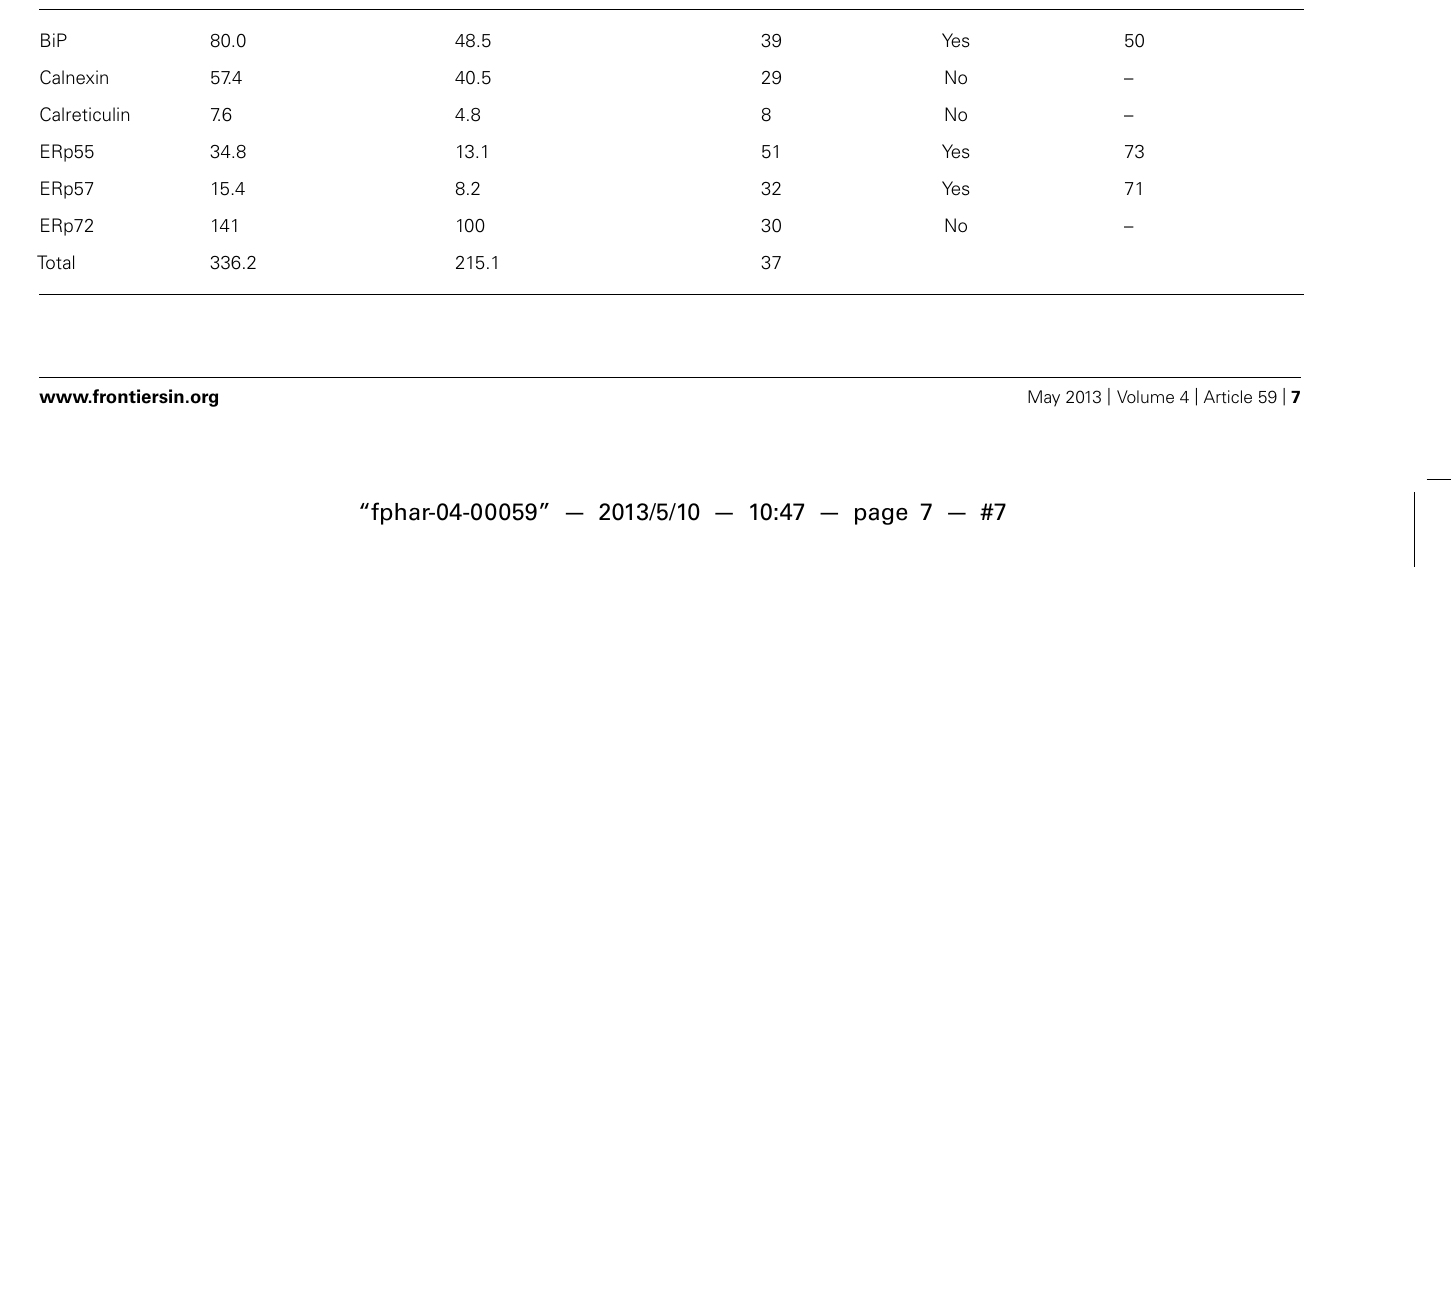
Table 2 | Effect of age on the content of rat liver ER chaperones (taken from Erickson etal., 2006).